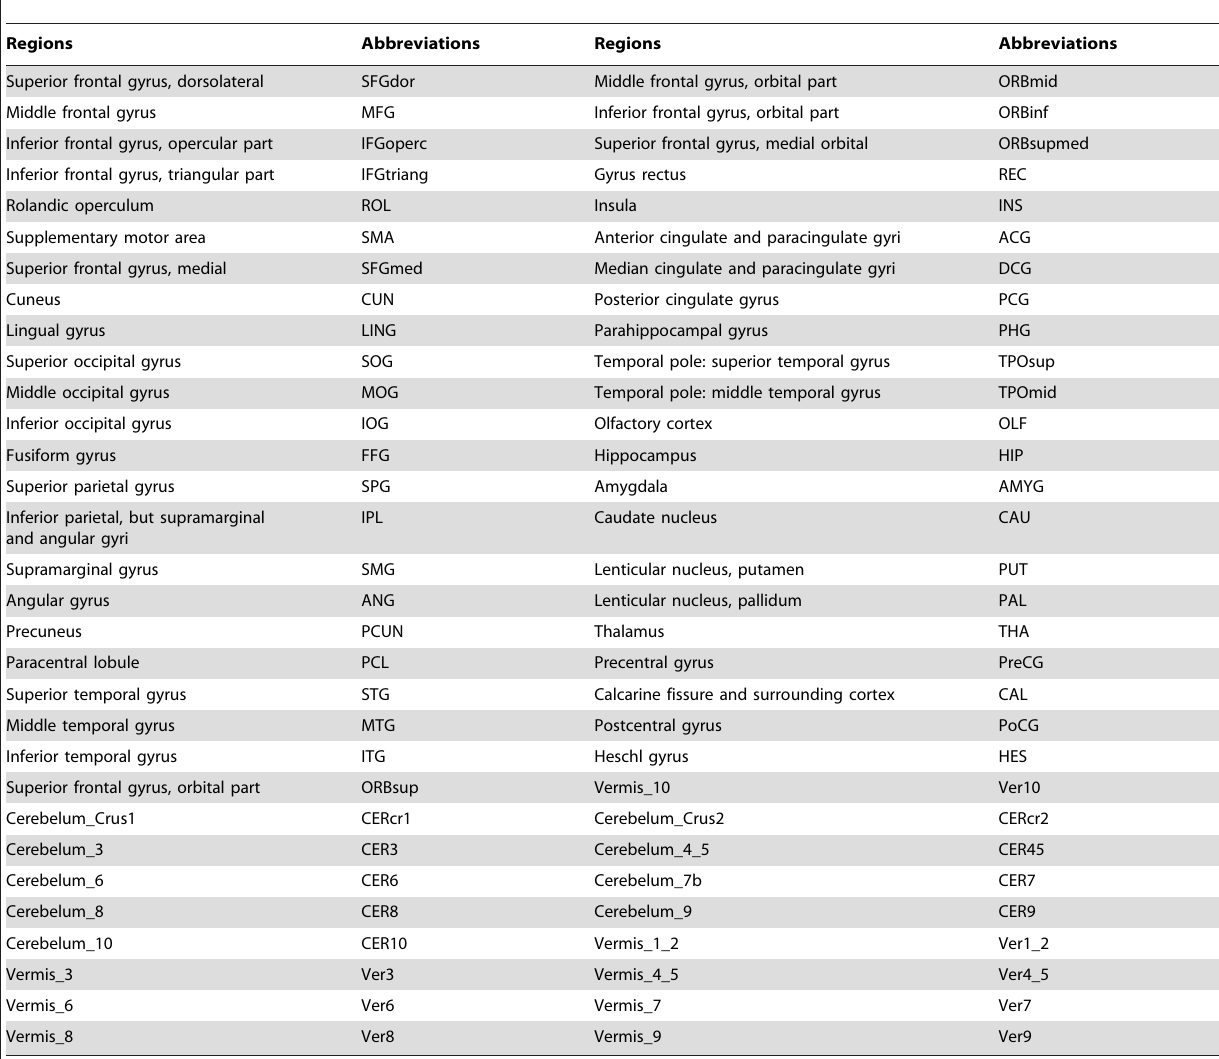
Table 2. Regions of interest (ROIs) included in the AAL-atlas.